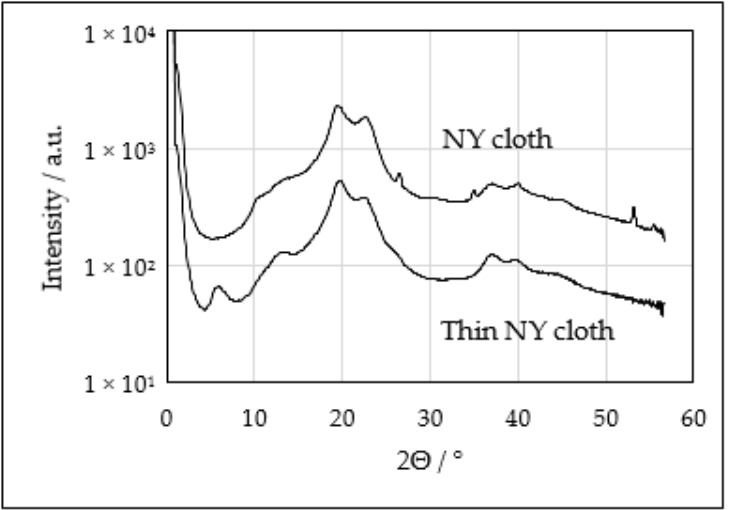
Figure 6. WAXS spectrum of thin NY-cloth and NY-cloth typical for tailings filtration.